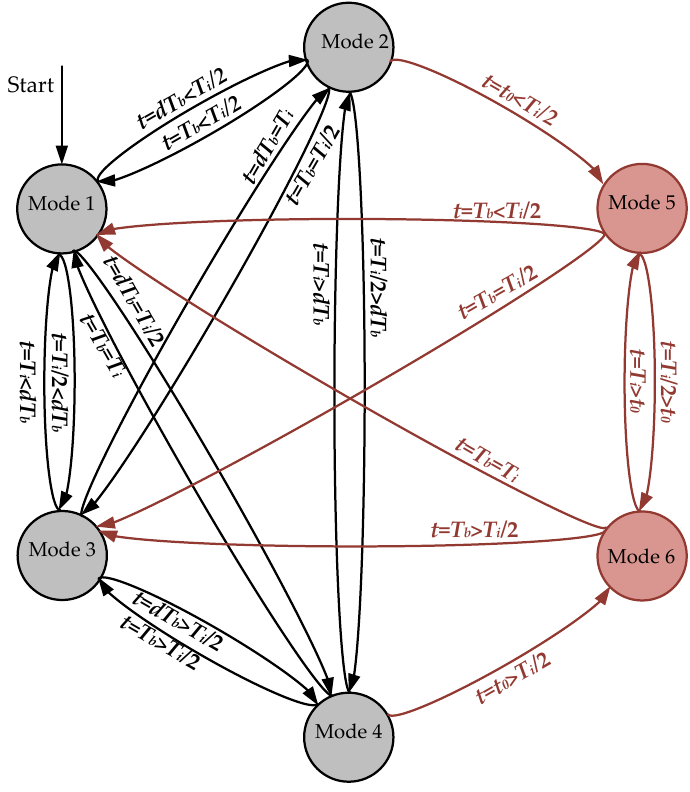
Figure 3. State-flow chart of Buck-inverter system.